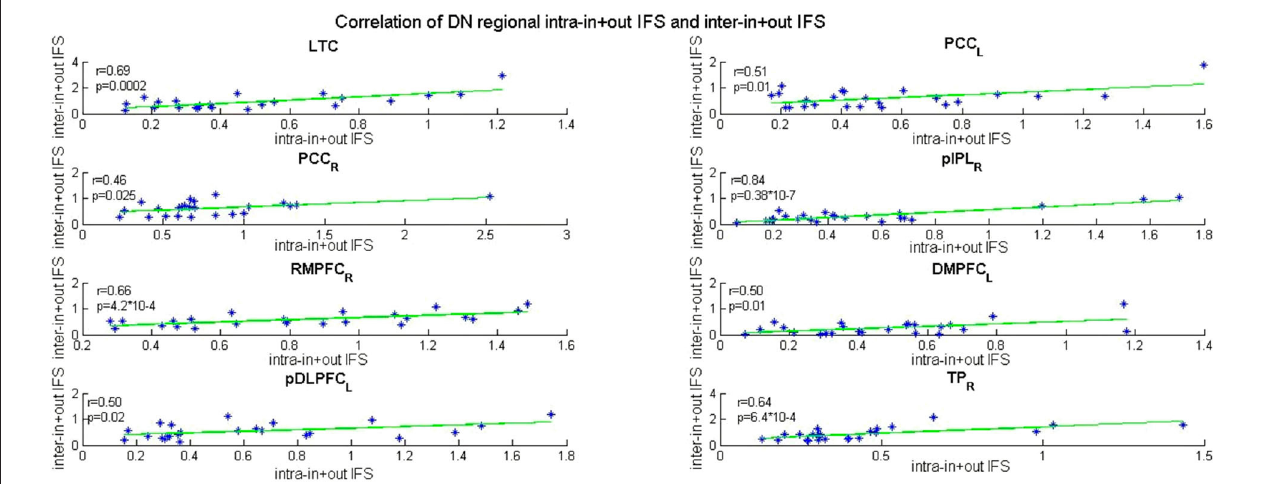
FIGURE 4 | Correlation of decreased DN regional intra-in + out IFS and inter-in + out IFS in AD subjects ( P < 0.05, uncorrected for multiple comparisons). LTC, lateral temporal cortex; PCC, posterior cingulate cortex; pIPL, posterior inferior parietal lobule; RMPFC, rostromedial prefrontal cortex; DM, dorsomedial prefrontal cortex; pDLPFC, posterior dorsolateral prefrontal cortex; TP, temporopolar cortex; L, left hemisphere; R, right hemisphere; r, Pearson correlation coefficient.